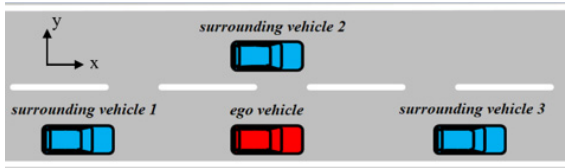
Figure 4. Training scenario.